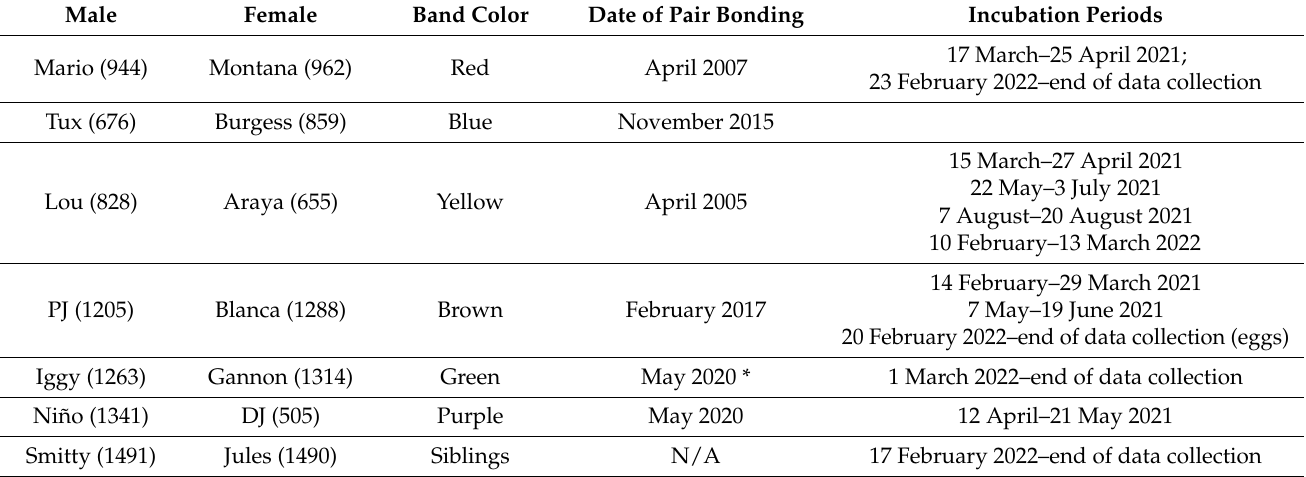
Table 1. Subjects of study. Studbook numbers follow the house names of all subjects. * = forced pairing. All pairs incubated dummy eggs with the exception of the “Brown”-banded pair. Dummy eggs are given to pairs who show nesting behavior but are not recommended to breed. Incubation periods span the length of the breeding season (approximately mid-February through mid-August). Date of Pair Bonding Incubation